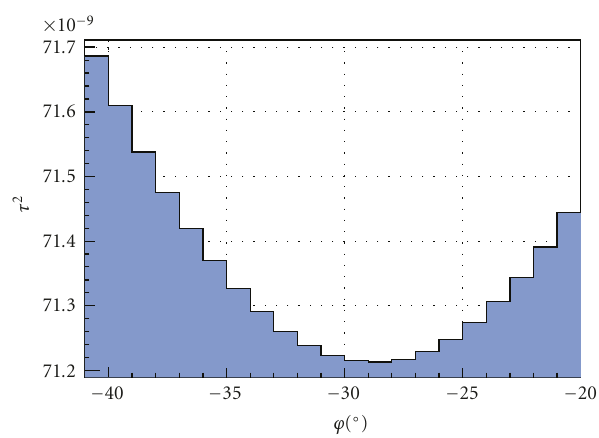
Figure 9: Cut through the θ − ϕ plane at θ min of the minimum computed with the time di ff erence method.